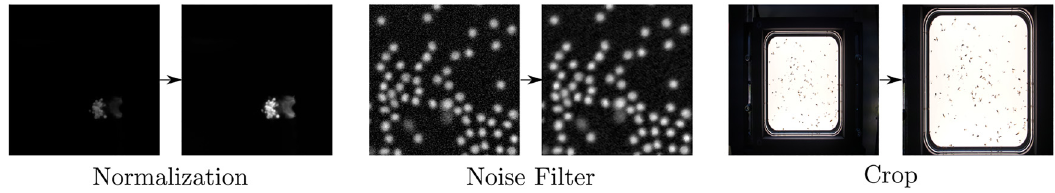
Figure 7: Illustration of methods in pre-processing. Exemplary results of normalization, noise filter, or crop are presented.